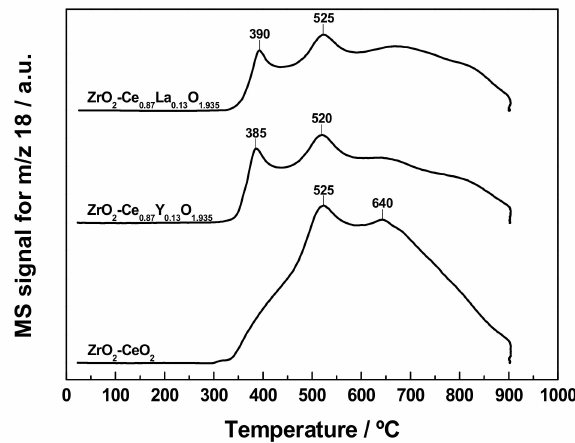
Figure 5. TPR-MS profiles registered for the fresh undoped and Ln-doped ZrO 2 -CeO 2